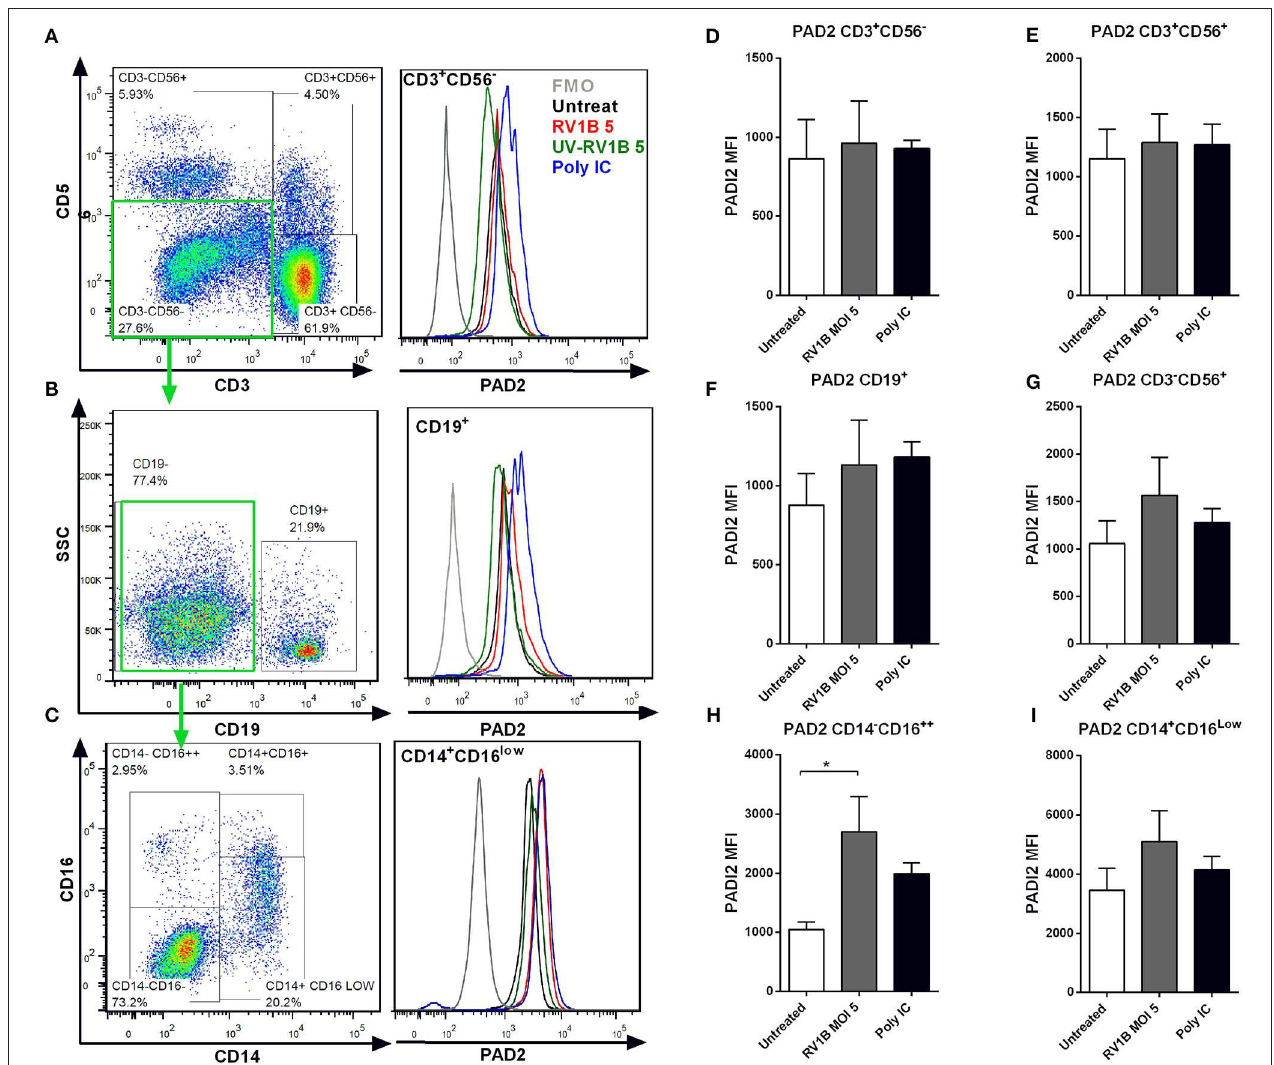
FIGURE 4 | Human rhinovirus and Poly I:C stimulation increase PAD2 expression in CD14 − CD16 ++ PBMCs. Peripheral blood mononuclear cells (PBMC) were isolated and exposed to different doses of HRV (viral MOI of 1 or 5) or to 10 µ g/ml of Poly I:C for 24 or 48h. Intracellular PAD2 expression was assessed in different PBMC subsets by FACS. Dot plots indicate the gating strategy used and histogram overlays indicate representative PAD2 levels (MFI) in different PBMCs subsets, (A) CD3 + CD56 − T-cells, (B) CD19 + CD3 − CD56 − B-cells, and (C) CD14 + CD16 low CD19 − CD3 − CD56 − Monocytes. Bars represent the Mean Fluorescence Index (MFI) of PAD2 levels expressed in each PBMC subset after 48h of infection: (D) T-cells, (E) NK-T cells, (F) NK-cells, (G) B-cells, (H) CD14 − CD16 ++ monocytes, and (I) CD14 + CD16 low monocytes. Bars indicate the mean ± SEM of three different experiments. Statistical analysis was performed by a one way ANOVA with Tukey’s multiple comparisons test (* p ≤